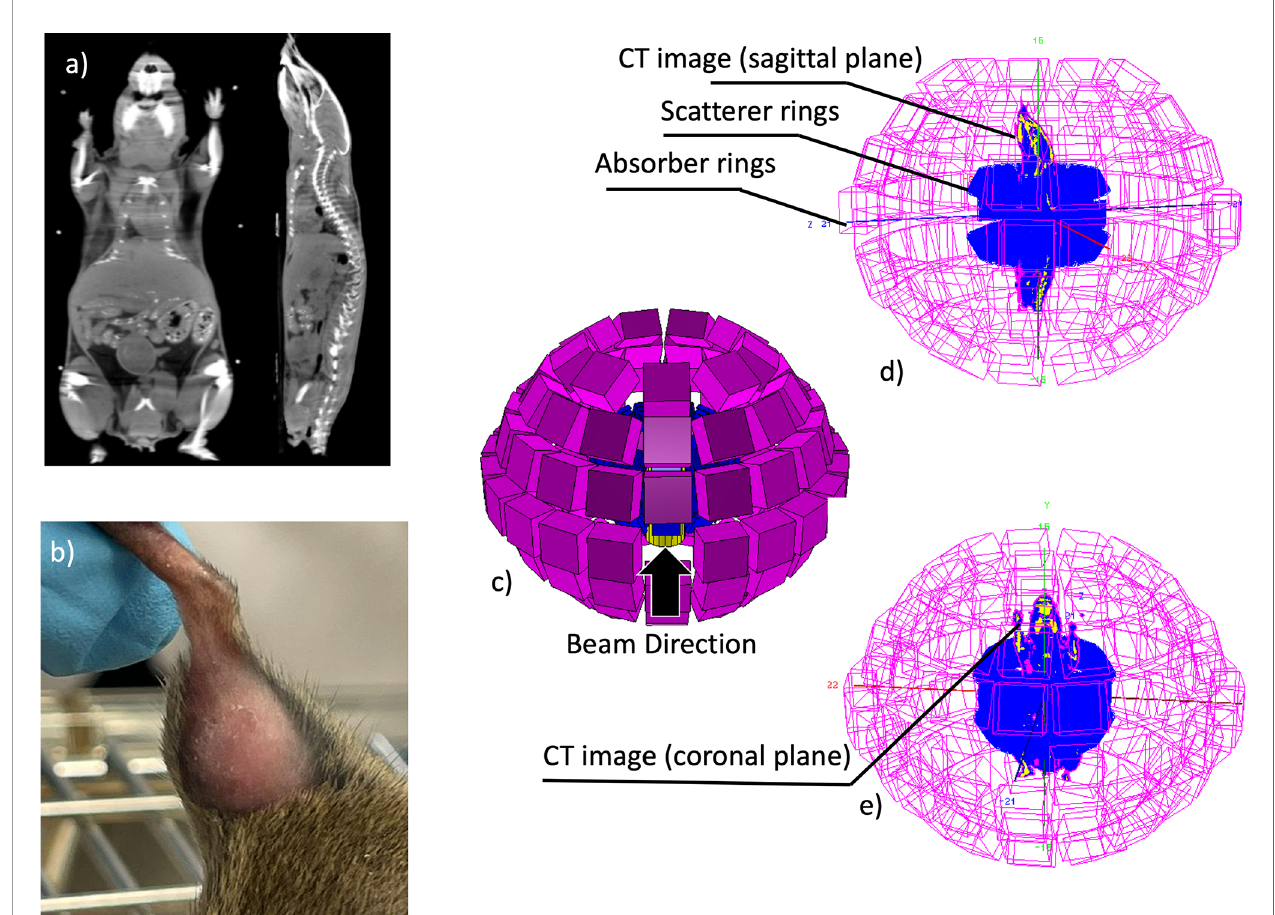
FIGURE 9 | (A) Mouse CT image, coronal and sagittal planes, (B) example of an osteosarcoma in the C3H mouse hind limb; (C) the proposed hybrid Compton- PET scanner for the radioactive ion beam range veri fi cation, (D, E) the scanner con fi guration with the CT image of the mouse (sagittal and coronal planes are plotted, respectively) positioned along the scanner